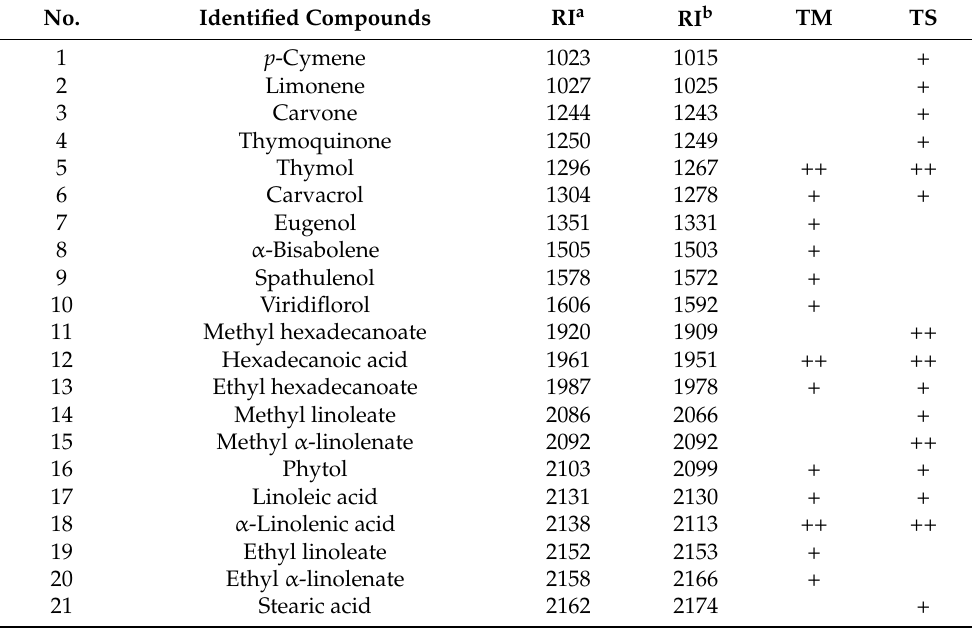
Table 3. Comparison of the volatile compounds occurring in the hexane fractions of hydroethanolic extracts of the aerial parts of Thymus marschallianus (TM) and Thymus seravschanicus (TS). No. Identified Compounds RI